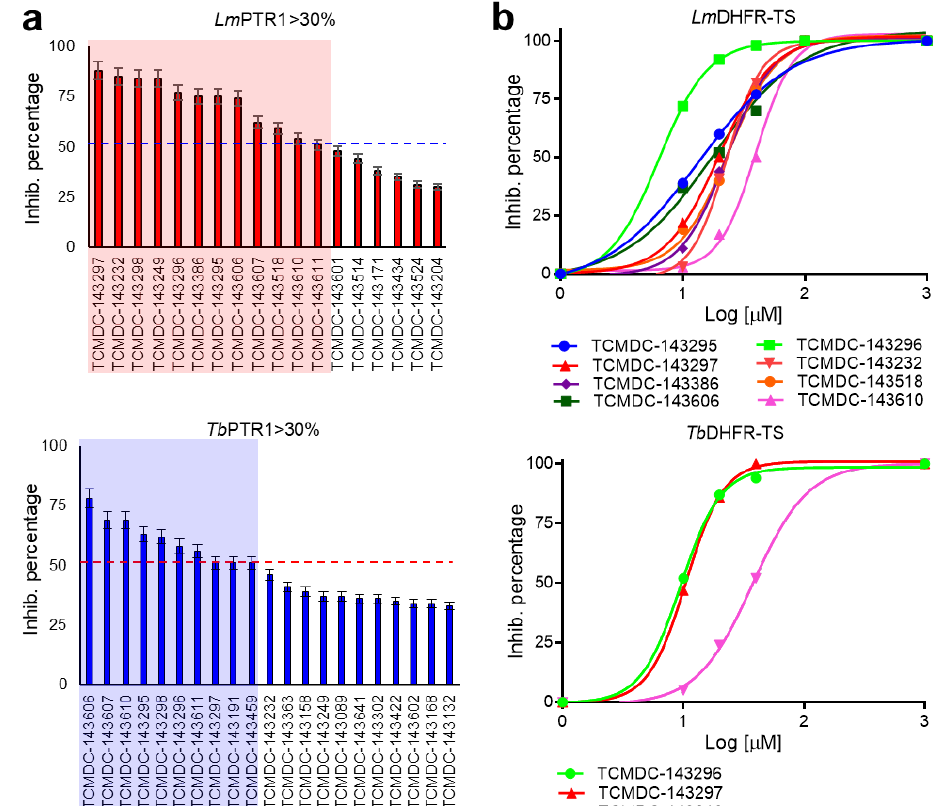
Figure 2. First in vitro screening assay on Lm/Tb PTR1 and Lm/Tb DHFR-TS, and IC 50 evaluation. ( a ) The percentage values of inhibition of the compounds inhibiting PTR1 enzymes with an efficacy cut-off value ≥ 50% at 10 µ M (red and blue square for Lm and Tb PTR1, respectively). Among these, a subset of 14 compounds, including 10 pan-inhibitors and 4 additional compounds inhibiting the recombinant protein of one single parasitic agent, was selected as starting point for the secondary screening on Lm/Tb DHFR-TS. ( b ) The resulting four-parameter Hill dose–response curve of the most potent compounds active on DHFR-TS protein from L. major and T. brucei . Only 3 compounds showed inhibition efficacy for Tb DHFR-TS in a medium-high micromolar range (9.7–38.2 µ M); 8 compounds showed IC 50 values in 6.9–40.0 µ M range against Lm DHFR-TS.